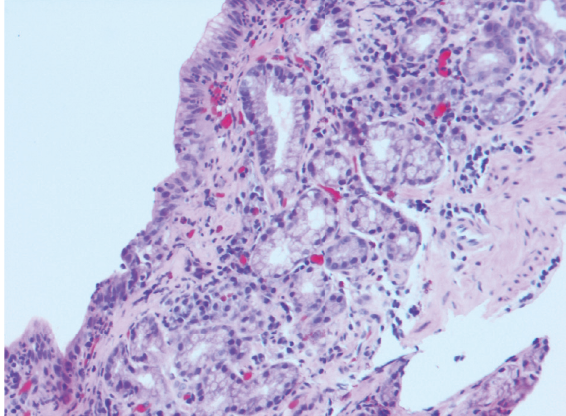
Figure 2: Histological section of gastric body showing focal mild atrophic change and area of subepithelial collagen deposit on hematoxylin and eosin stain. There is mild chronic gastritis. The surface epithelium is atrophic with intraepithelial neutrophils.